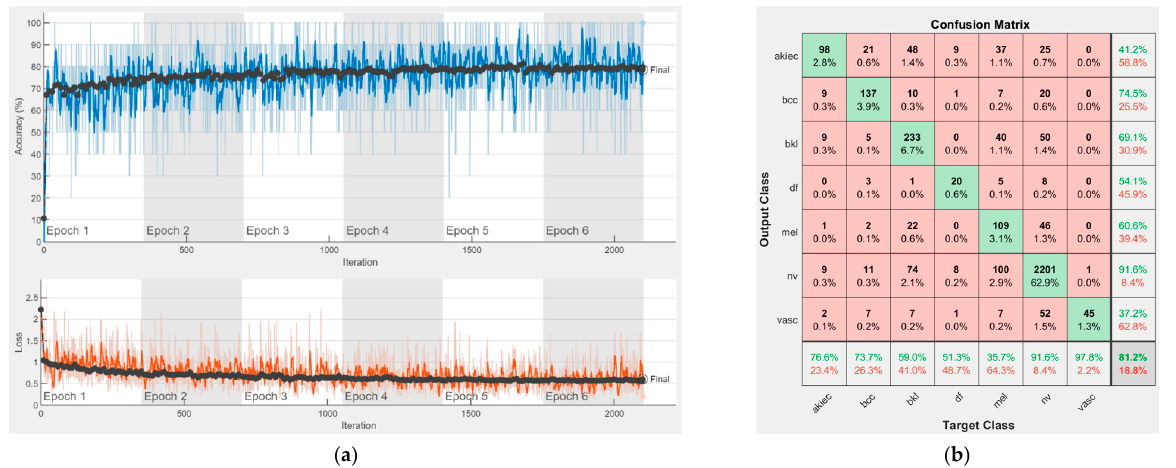
Figure 15. Results using DenseNet-201, ( a ) Accuracy and loss, ( b ) Confusion matrix.